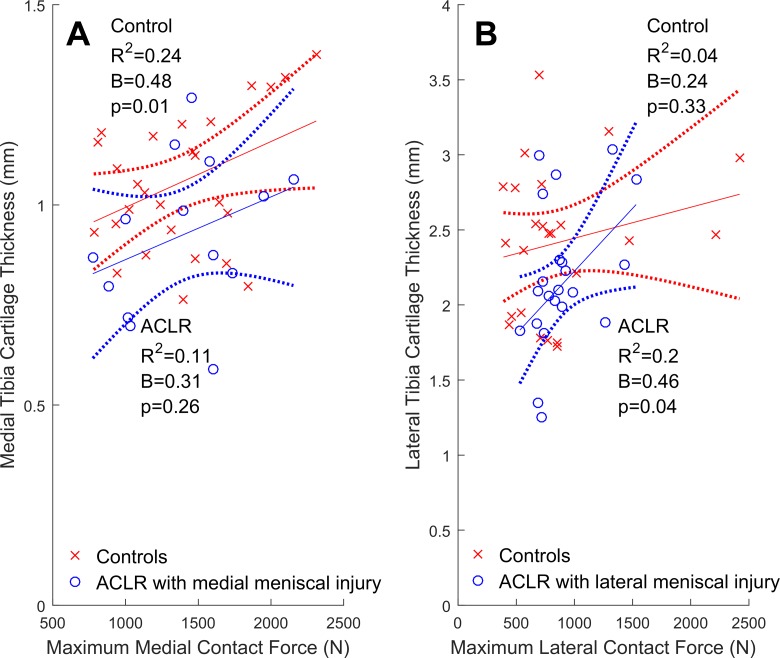
Tibial articular cartilage thickness (mm) from the compartment that sustained a meniscal injury regressed onto maximum contact forces (N) from the respective tibiofemoral compartment with 95% confidence intervals (dotted lines). Shown are ACLR participants (circles) with (A) medial meniscal injury (n = 17) and (B) lateral meniscal injury (n = 25), while healthy controls (cross-hairs) are plotted for comparision. ACLR, anterior cruciate ligament reconstruction.